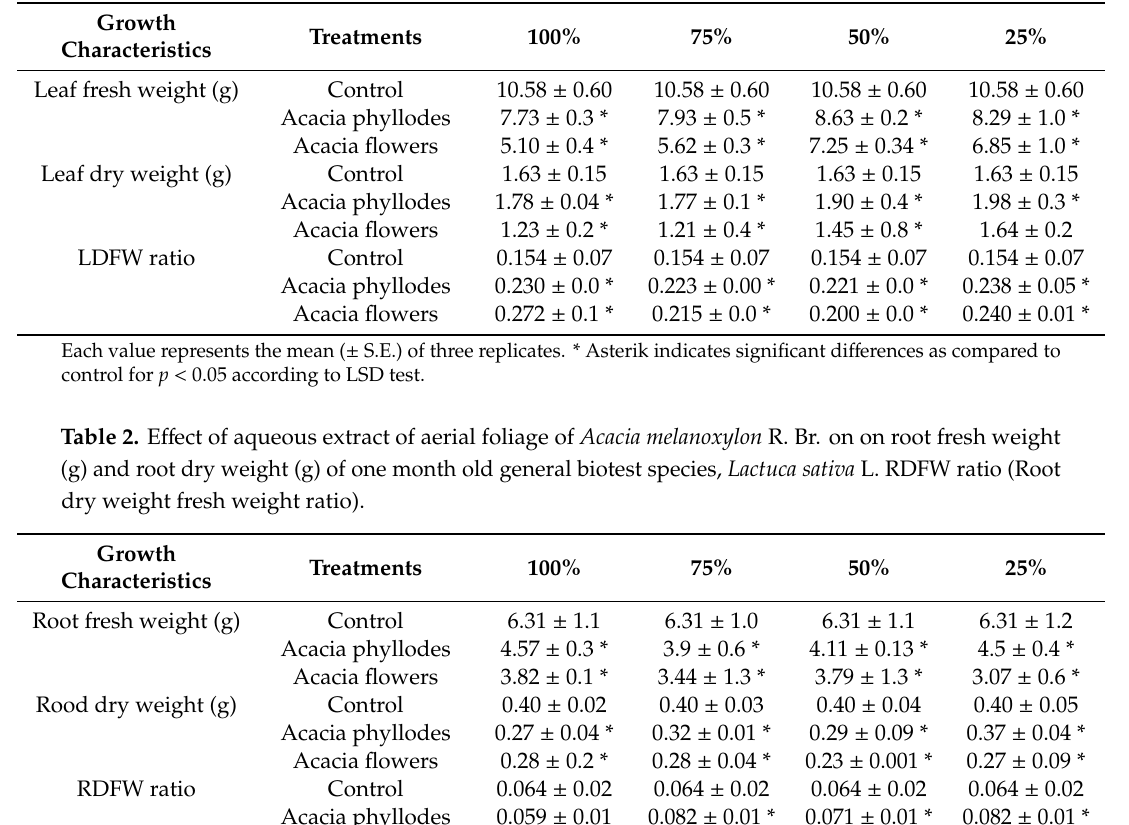
Table 1. E ff ect of aqueous extract of aerial foliage of Acacia melanoxylon R. Br. on leaf fresh weight (g) and leaf dry weight (g) of one month old general biotest species, Lactuca sativa L. LDFW ratio (Leaf dry weight fresh weight ratio).